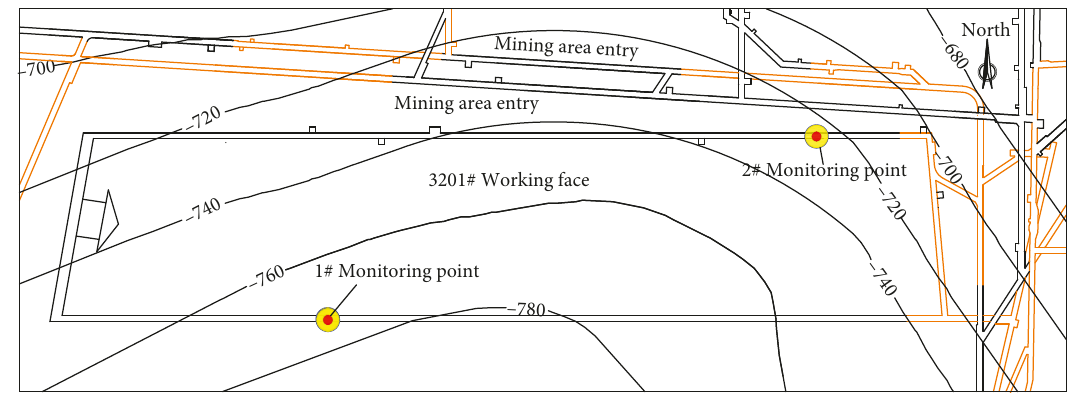
E 0 C ” distribution curve of the abutment pressure peak.